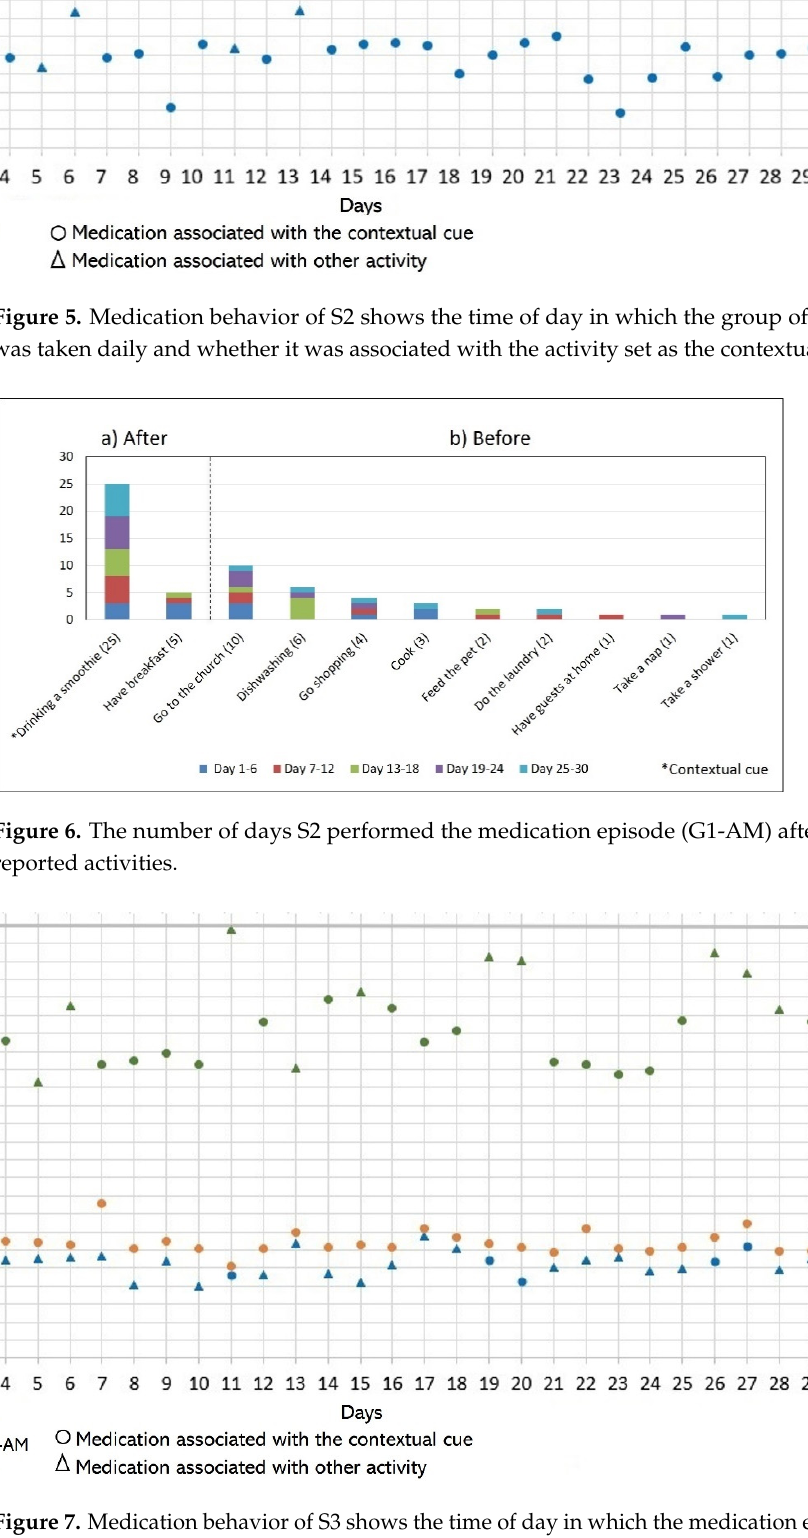
Figure 8. The days that S3 performed their medication episodes (G1-AM, G2&G3-AM, and G3-PM) after and before the reported activities. Subject #4 (S4) reported taking once-daily doses of six medications that he kept on the dining table (see Figure 2d). To avoid stomach problems, he formed three groups of drugs to be taken 15 min apart. In the initial interview, he reported that the first medica- tion (G1) was taken after getting dressed, the medications of G2 were taken while making coffee, and the medications of G3 were taken after having breakfast. The usage rates of